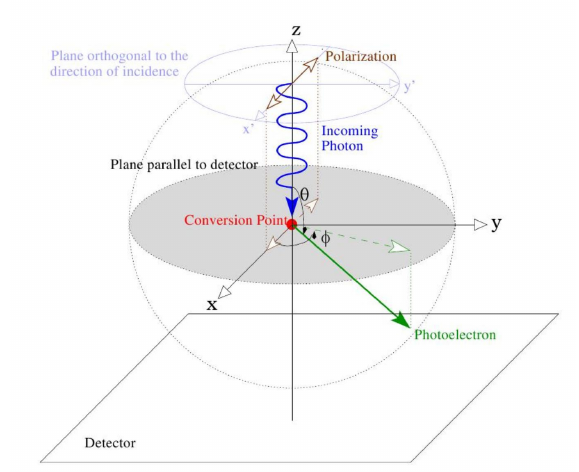
Figure 3. Scheme of the photoelectric effect absorption. See Equation